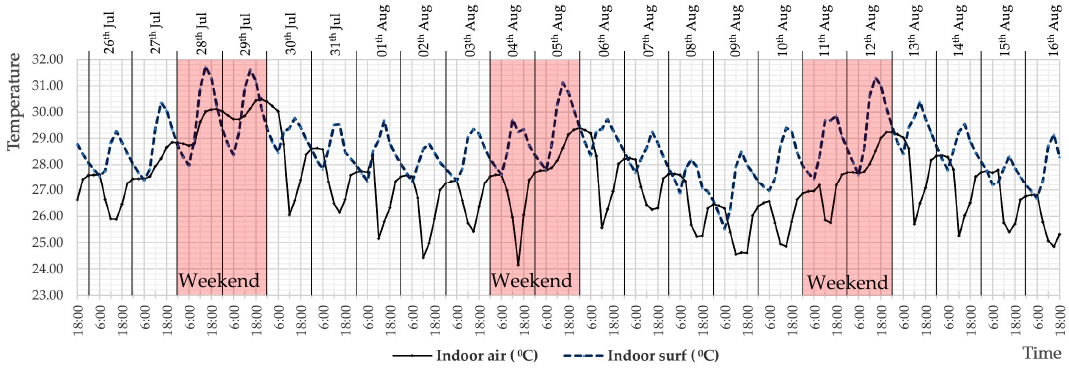
Figure 9. Wall surface and indoor air temperature behavior in Building “B”.